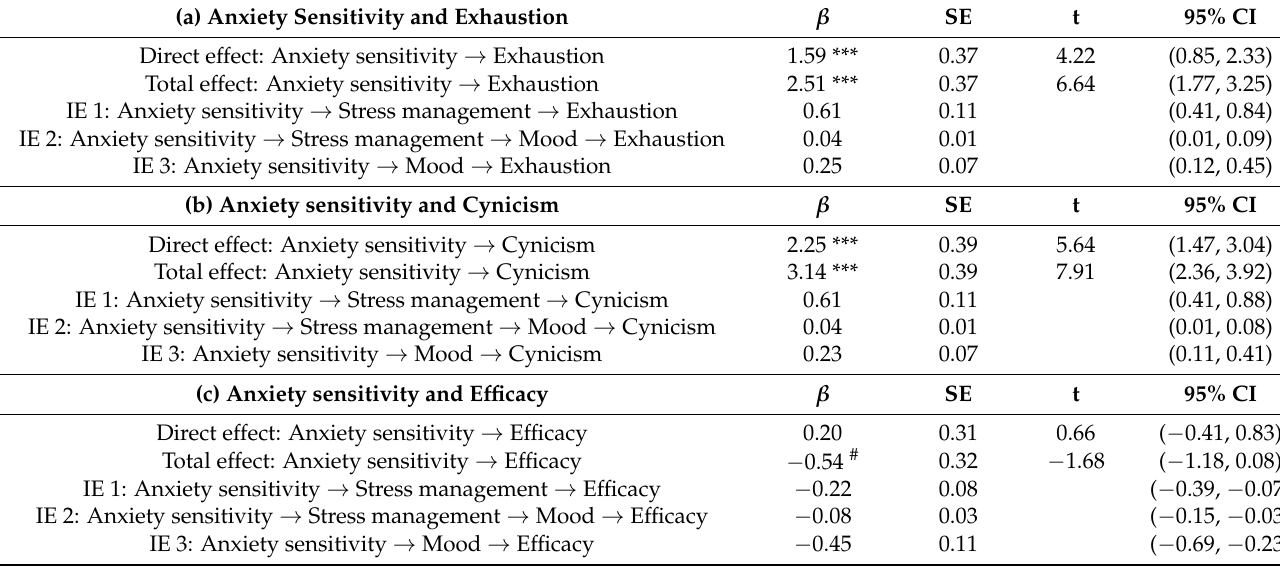
Table 3. Direct, total, and indirect effects.